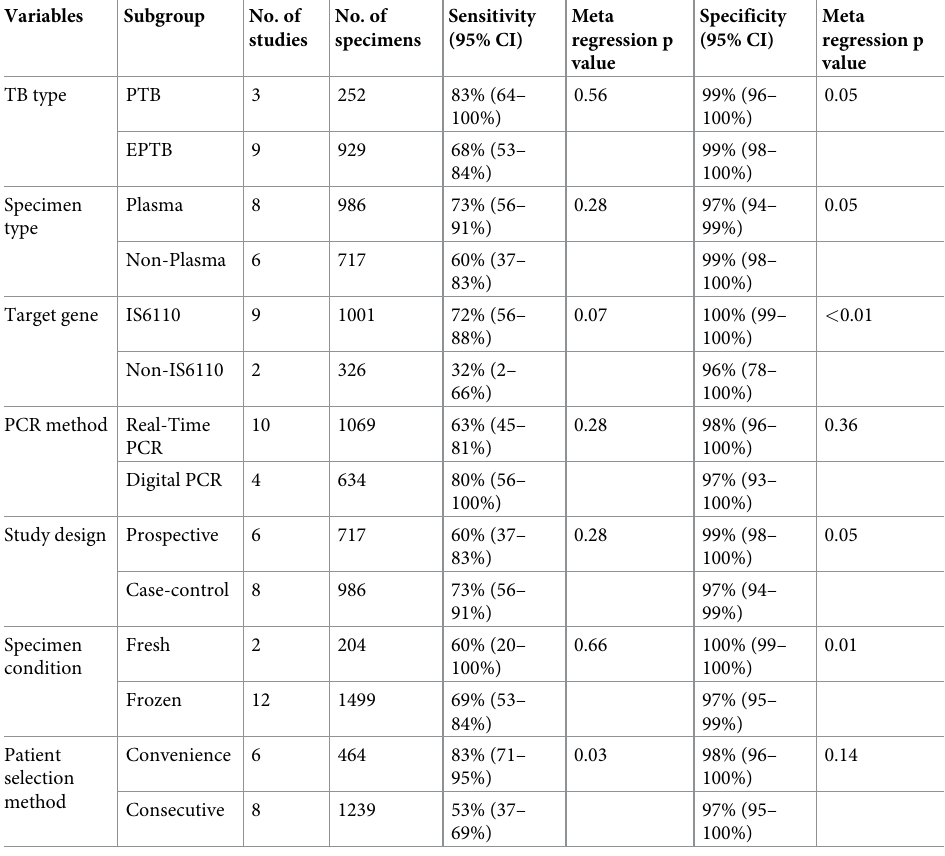
Table 2. Meta-regression analysis for different parameters compared with composite reference